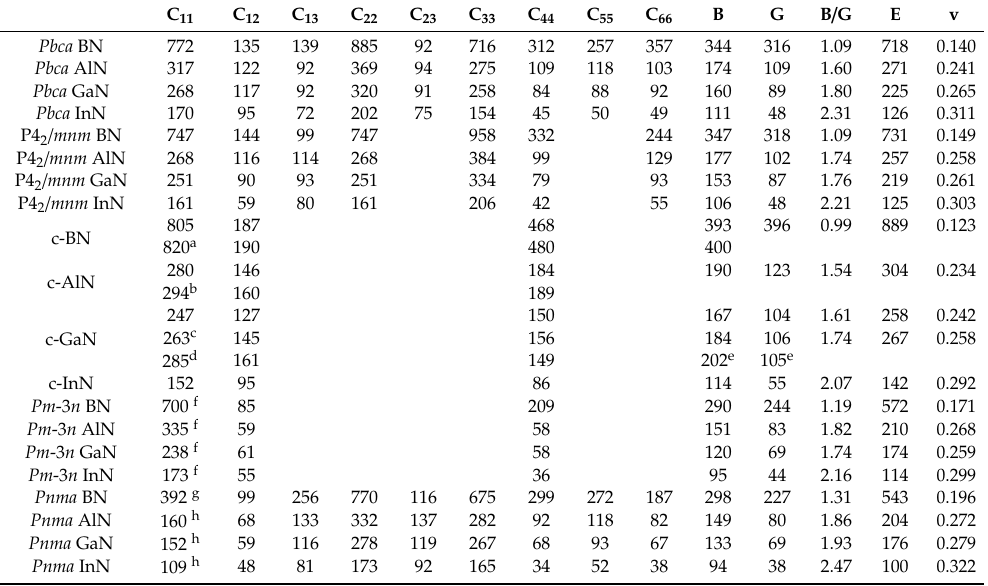
Table 2. Elastic constants (GPa) and elastic moduli (GPa) of Pbca XN, P 4 2 / mnm , c-XN, Pm -3 n XN and Pnma